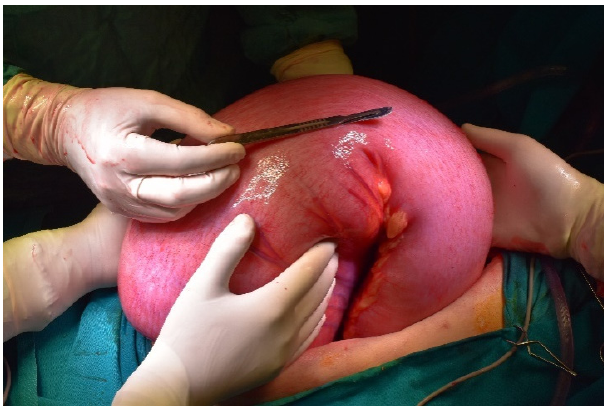
Figure 9 . Intraoperative picture. Assessing the size of the colon.